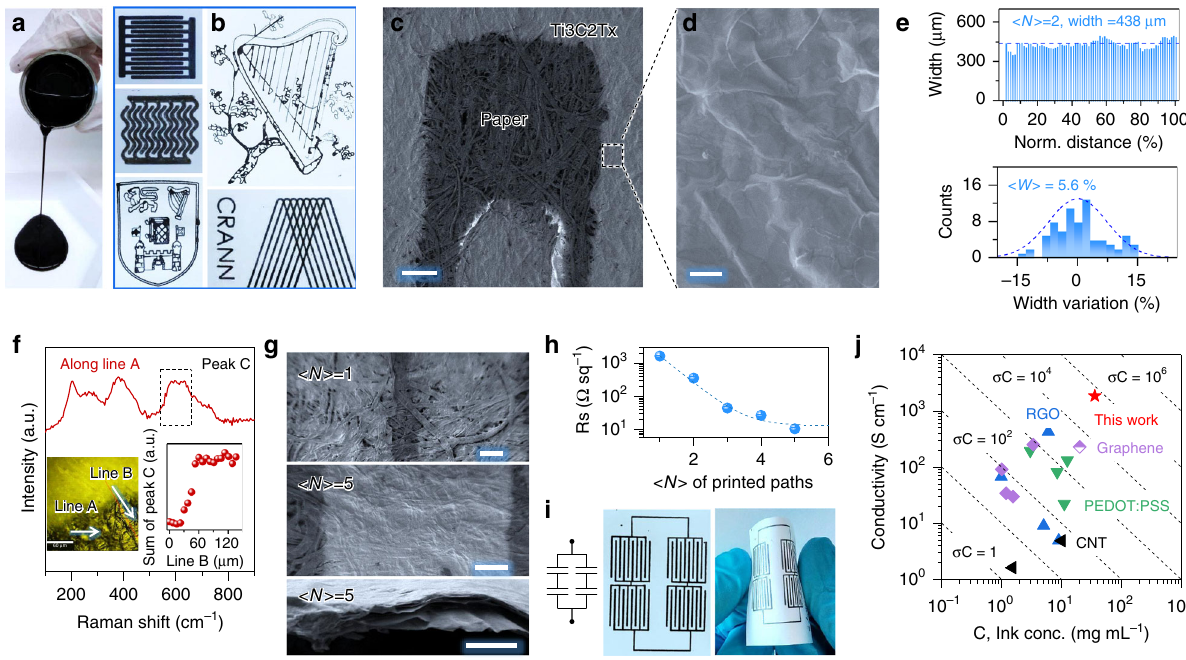
Fig. 4 Extrusion printing of MXene viscous aqueous inks. a Photo of MXene aqueous ink, showing its viscous nature. b Optical images of all-MXene